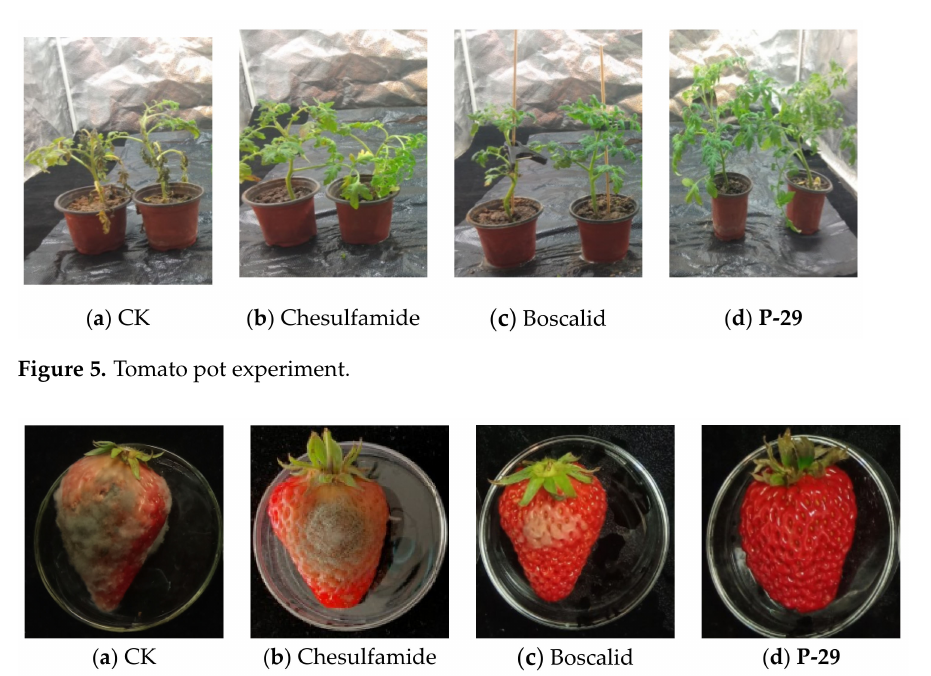
Figure 6. Strawberry